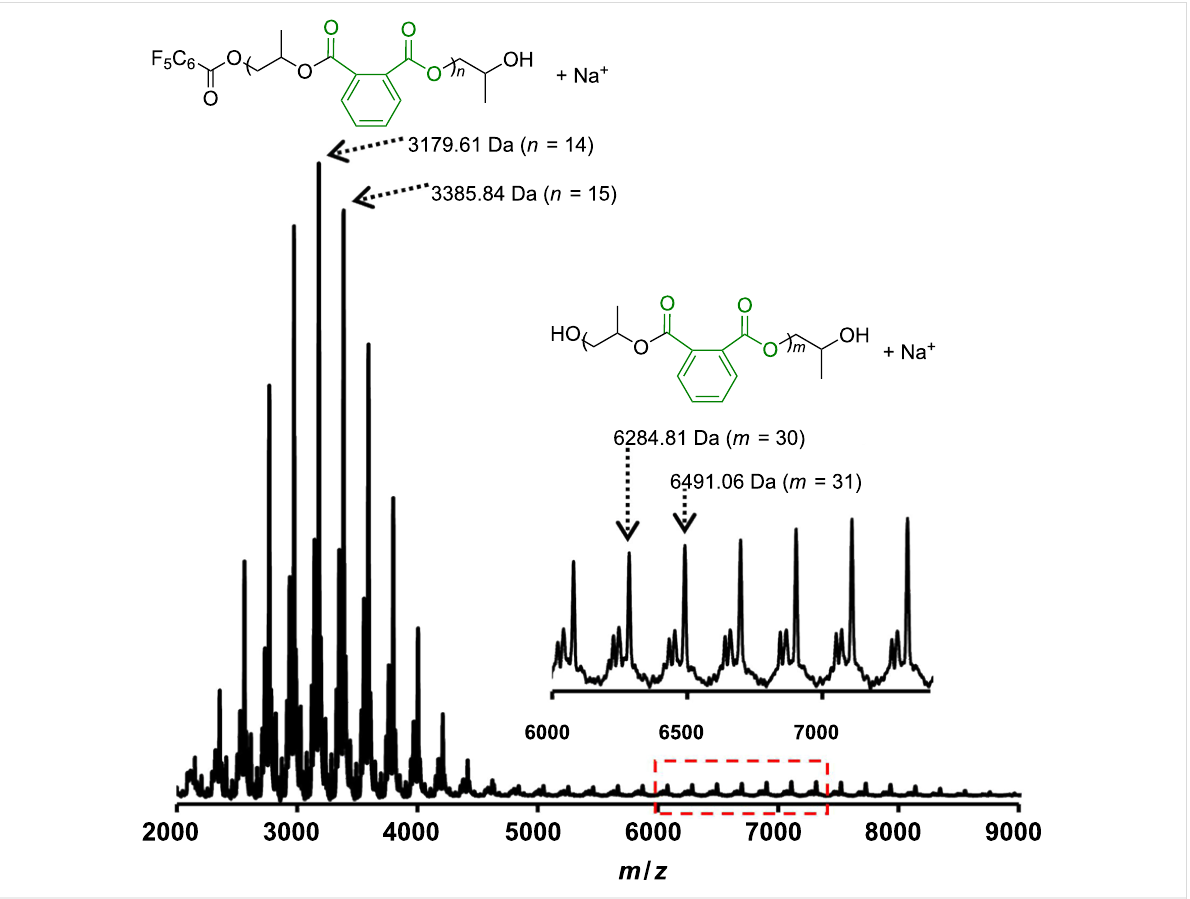
Figure 2: MALDI–TOF mass spectrum of the PO/PA copolymer. The low molecular weight copolymer for MS analysis was prepared by using ( R , R , R , R )- 1 at 30 °C for 15 min.